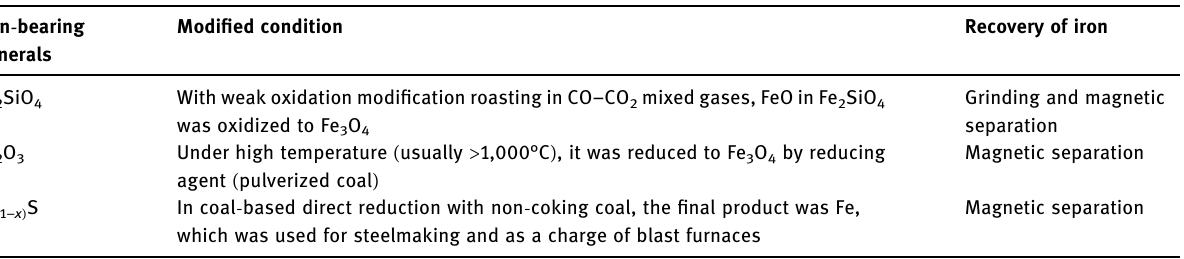
Table 1: The modi fi ed conditions with iron - bearing minerals Iron - bearing Modi fi ed condition minerals